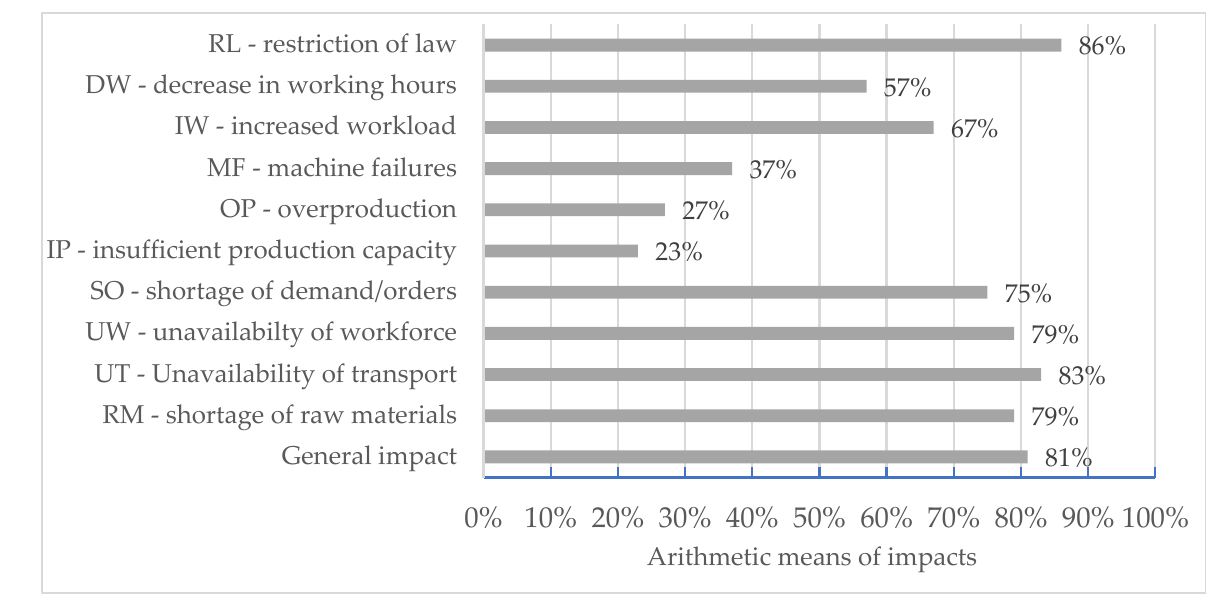
Figure 3. Collective arithmetic means of responses from sample on the extent of impacting factors.